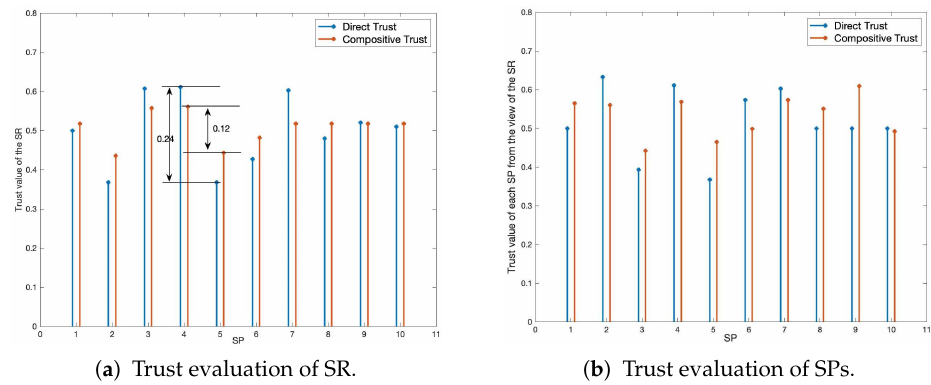
Figure 5. Bidirectional trust evaluation of SR and SPs.